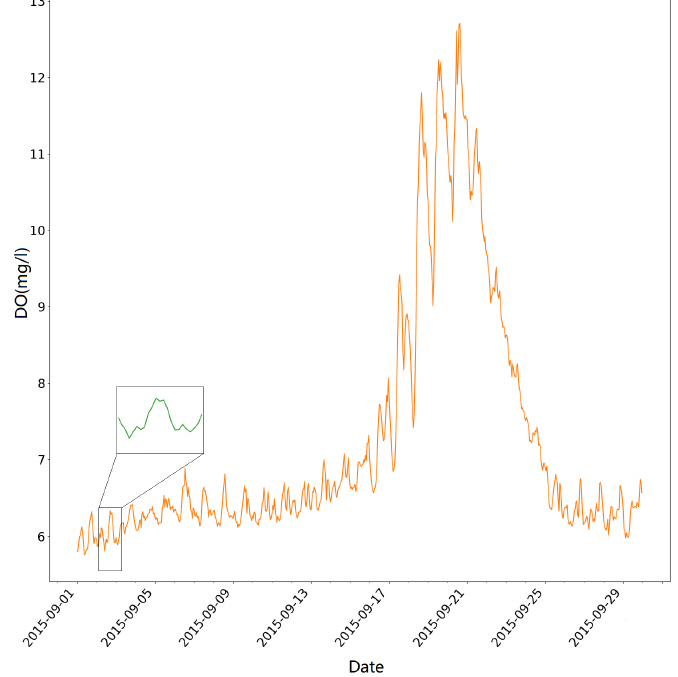
Figure 3. The concentration of DO measured in October 2015. The orange line describes the overall trend of DO concentration in this month. The green shape is an example of the daily pattern of DO concentration.